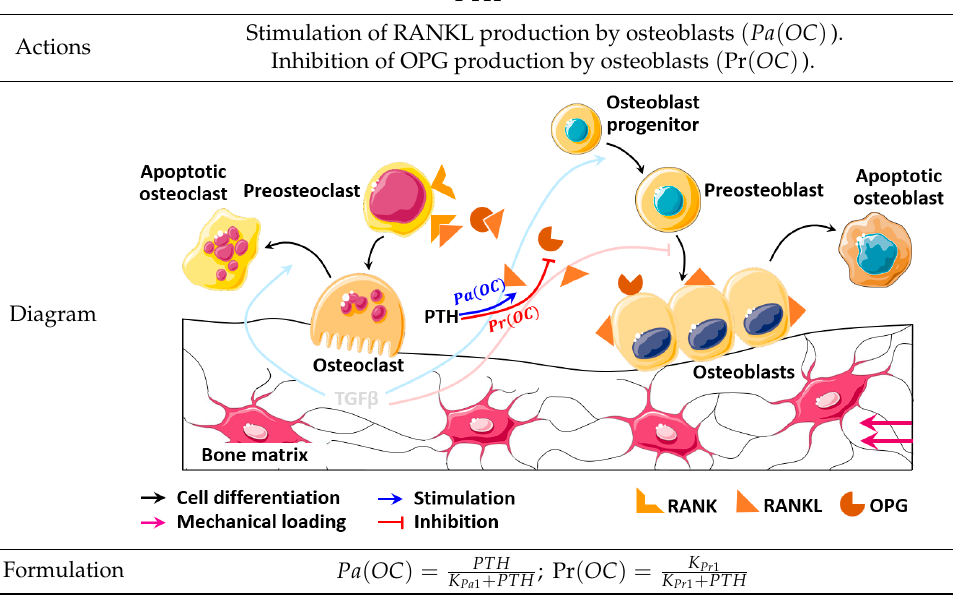
Table 2. PTH actions and their mathematical formulation.